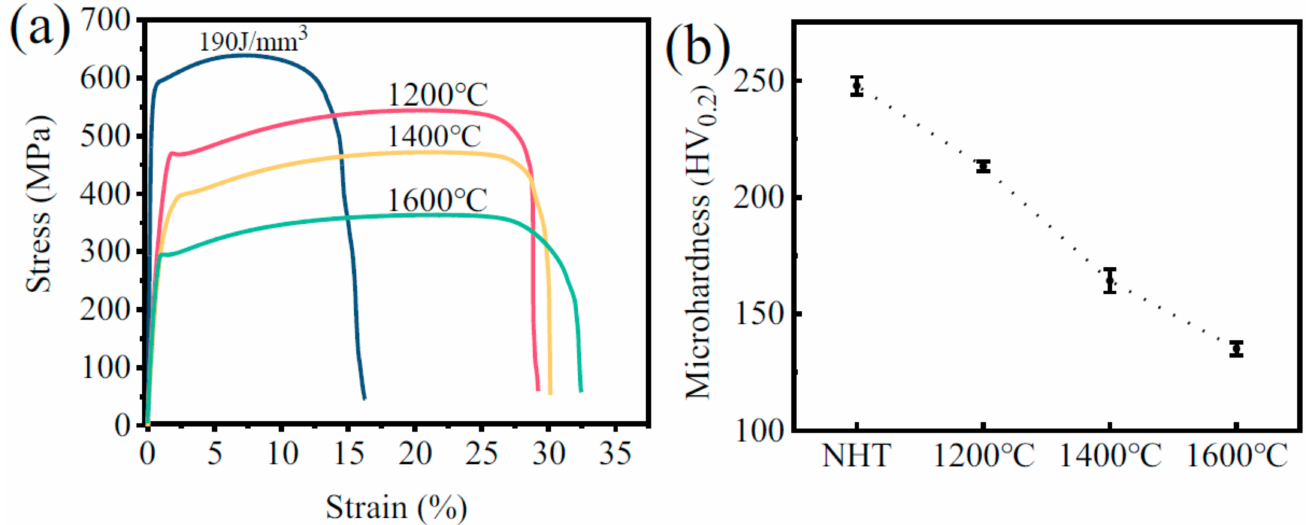
Figure 7. ( a ) Tensile stress–strain curves and ( b ) Microhardness of SLMed Ta made at 190 J/mm 3 after heat treatments of different temperature. (Note: NHT is the SLMed Ta prepared at 190 J/mm 3 without heat